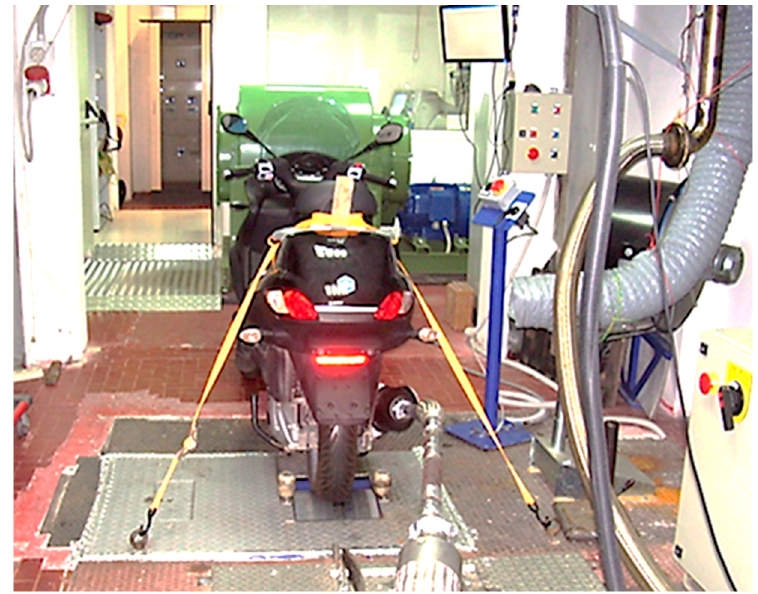
Figure 1. The motorcycle under examination on the test bench. Table 1. Technical specifications of the tested motorcycle [9].